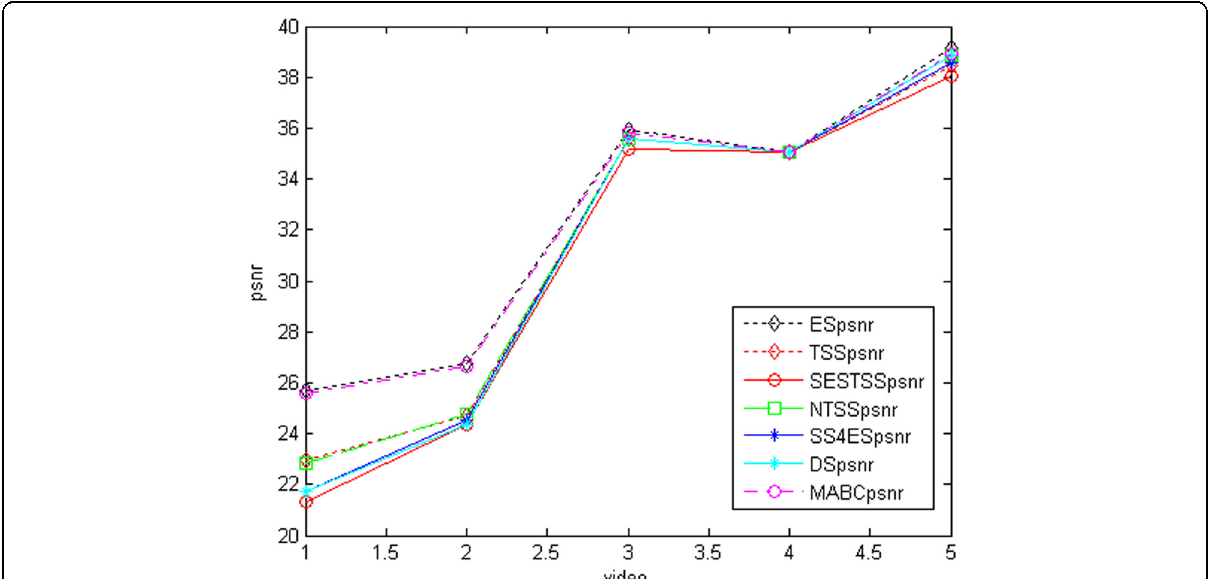
Fig. 3 Comparison of the average PSNR values of the five CIF sequences. Video 1 to video 5 respectively represent sequences “ Bus, ” “ Stefan, ” “ Hall_motion, ” “ Bridge_close, ” and “ News